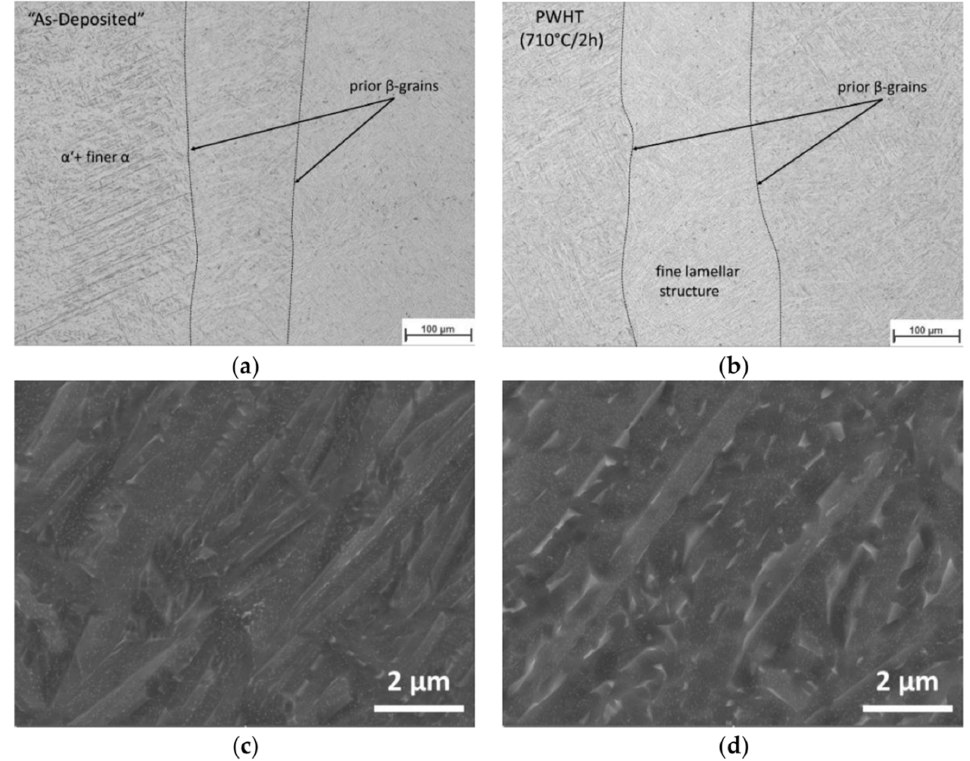
Figure 2. Microstructure of the AM block center: ( a ) as ‐ deposited and ( b ) post ‐ weld heat treatment condition (PWHT); detail of the microstructure by SEM investigations in ( c ) as ‐ deposited and ( d ) PWHT conditions [43].